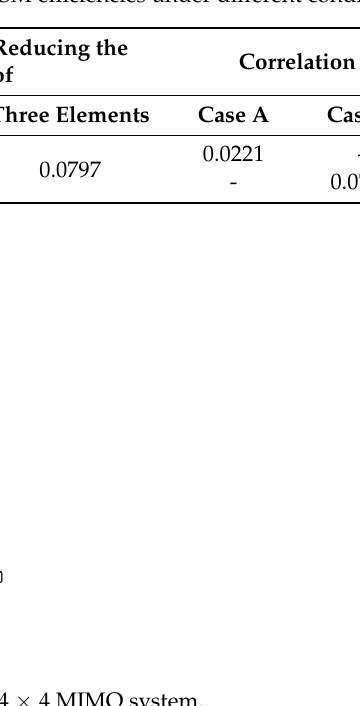
Figure 1. SM efficiency as a function of power-imbalance in 4 × 4 MIMO systems. ( a ) Power imbalance is introduced by reducing the efficiency of one element; ( b ) power imbalances are introduced by reducing the efficiencies of two elements to different values. The results are applicable to both case A and case B. Table 1. RMSEs (dB) between simulated and theoretical SM efficiencies under different conditions.